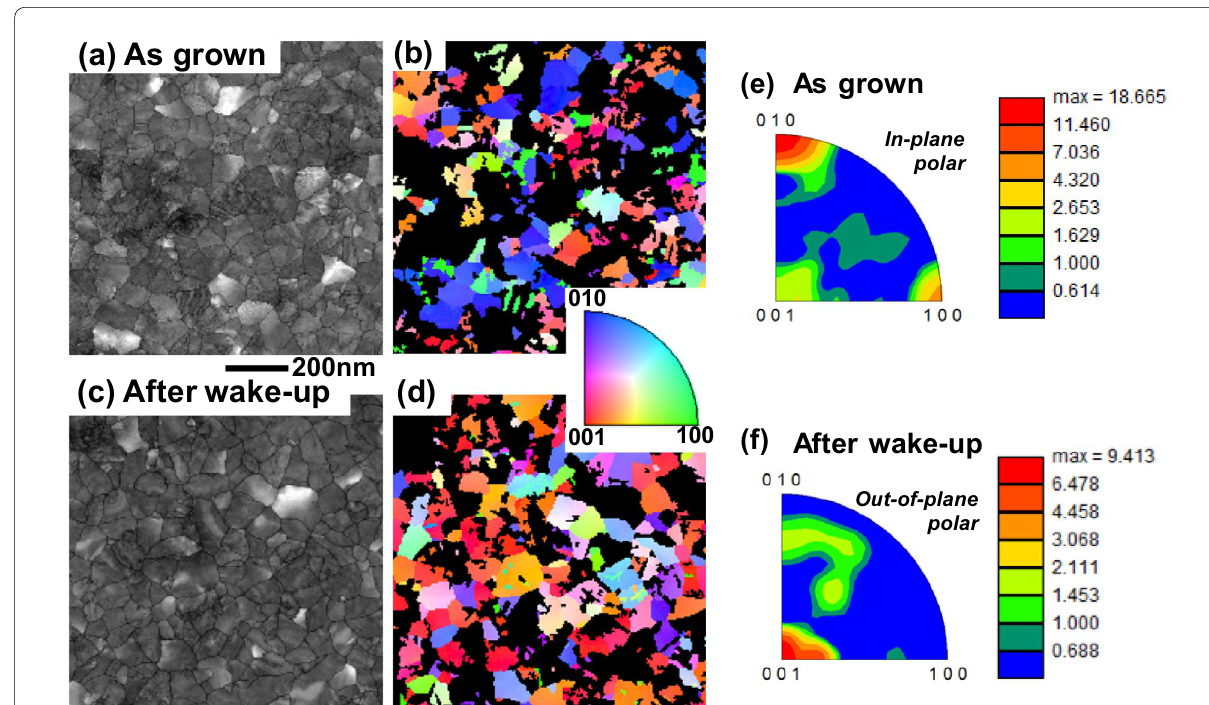
Fig. 9 Plan-view TEM images and crystal-orientation color-maps of HZO films ( a , b ) without and ( c , d ) with wake-up operation. Inverse polar maps ( e ) without and ( f ) with wake-up operation by 10 3 electrical